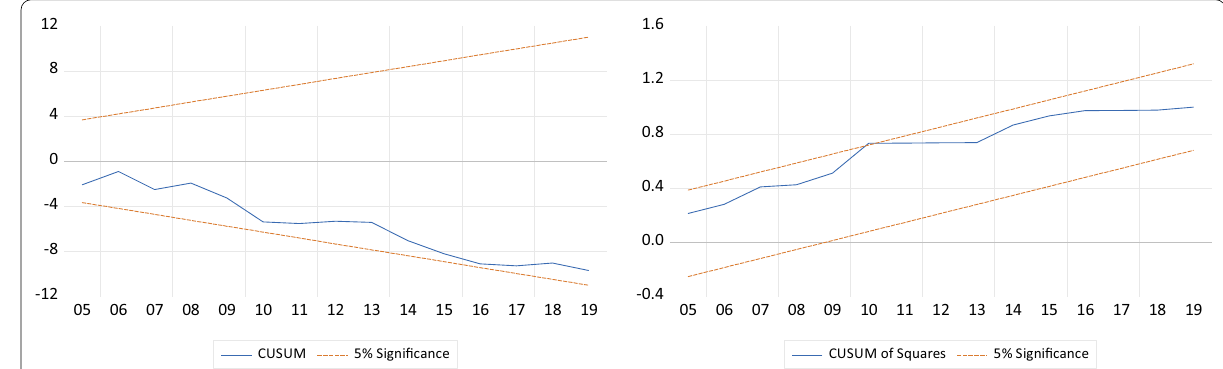
Fig. 4 CUSUM and CUSUMSQ long-run analysis stability tests of model 1